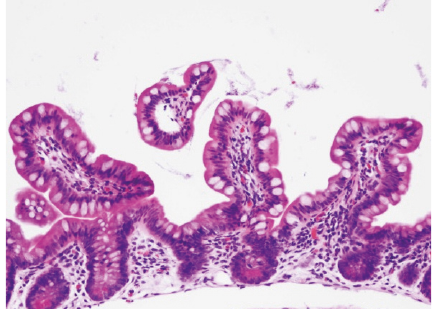
Figure 2: Photomicrograph of histopathology with H&E stain of biopsy specimen shows normal ileal mucosa prior to postoperative occurrence of prepouch ileitis, with relatively normal villous height and preserved villous-to-crypt